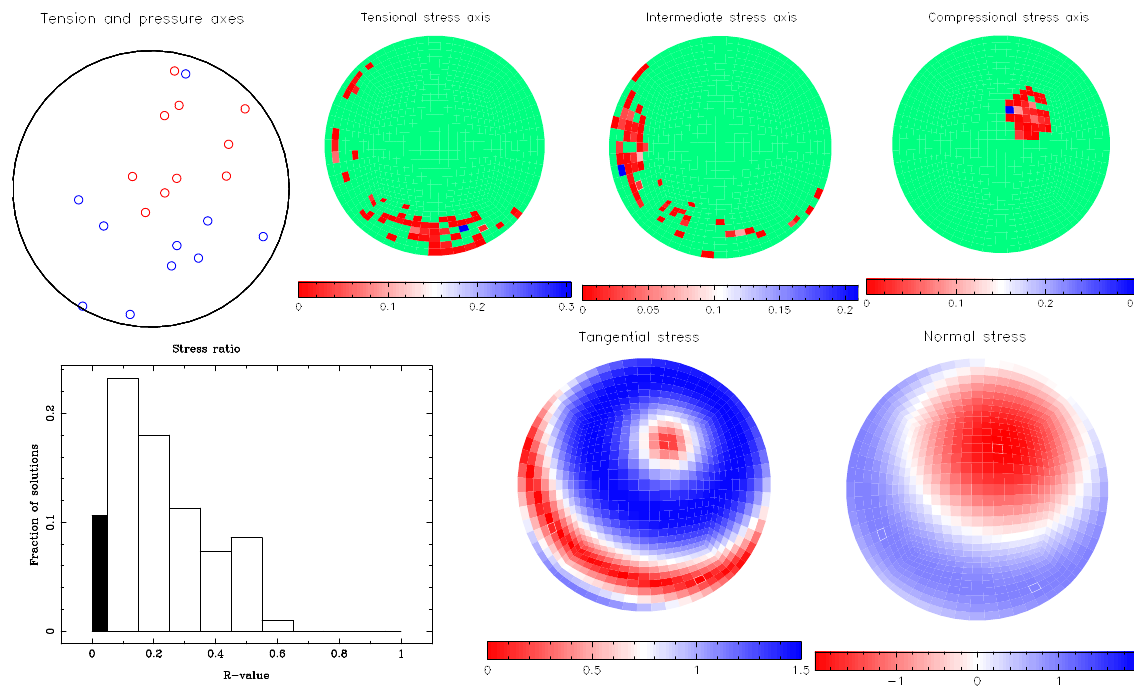
Fig. A1. Results of stress inversion for cluster of shallow earthquakes near Kos. Explanation of subfigures is as in Fig. 5. 22 W. Friederich et al.: Focal mechanisms and stress field in the Southern Aegean